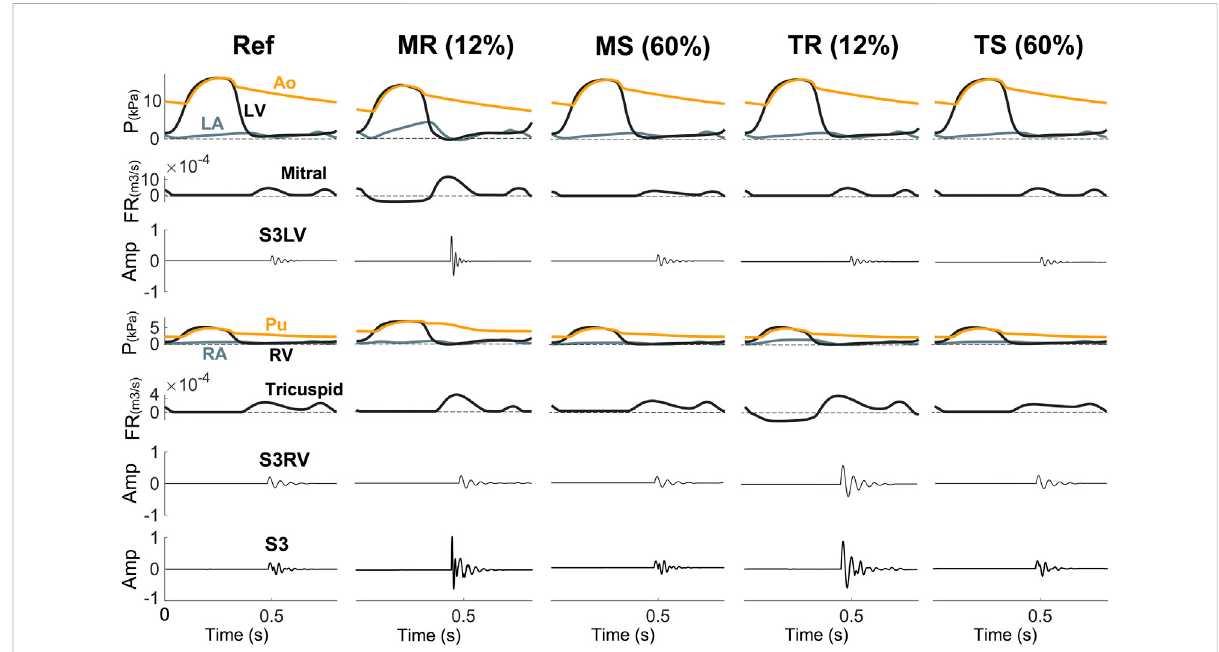
FIGURE 7 S3 is more common in disorders with leakage (MR, TR) than in stenotic lesions (MS, TS). Amp, amplitude; Ao, aorta; FR, fl ow rate; LA, left atrium; LV, left ventricle; MR, mitral regurgitation; MS, mitral stenosis; P, pressure; Pu, pulmonary artery; RA, right atrium; Ref, reference; RV, right ventricle; S3LV, left ventricular S3; S3RV, right ventricular S3; TR, tricuspid regurgitation; TS, tricuspid